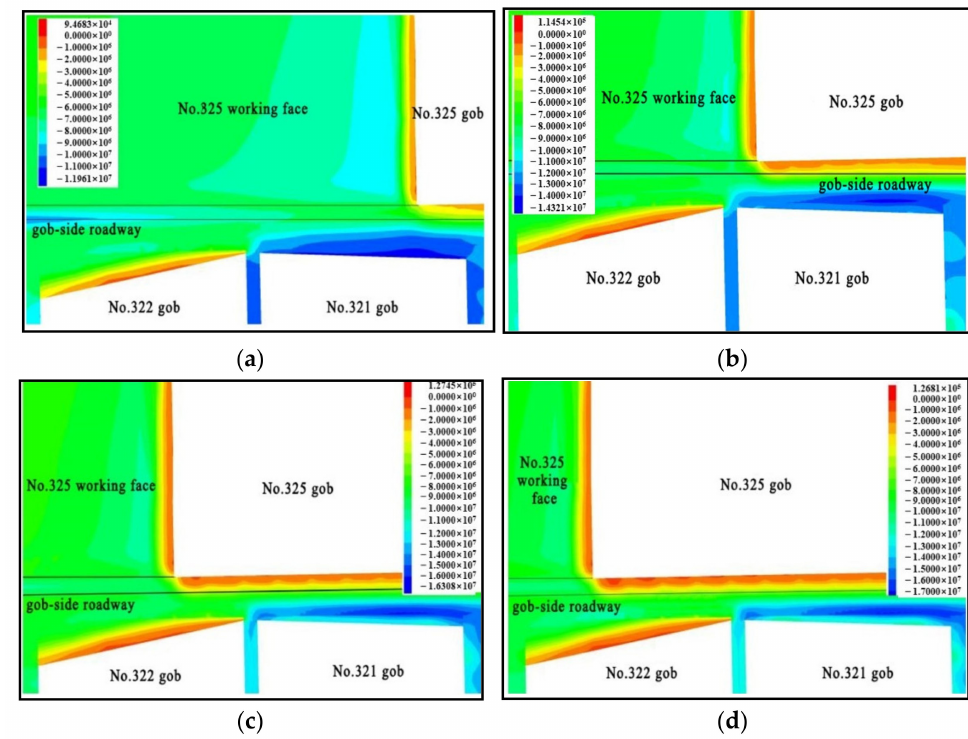
Figure 10. “Umbrella” coal pillar with open-roof 1.5 m vertical stress distribution: ( a ) 40 m; ( b ) 80 m;